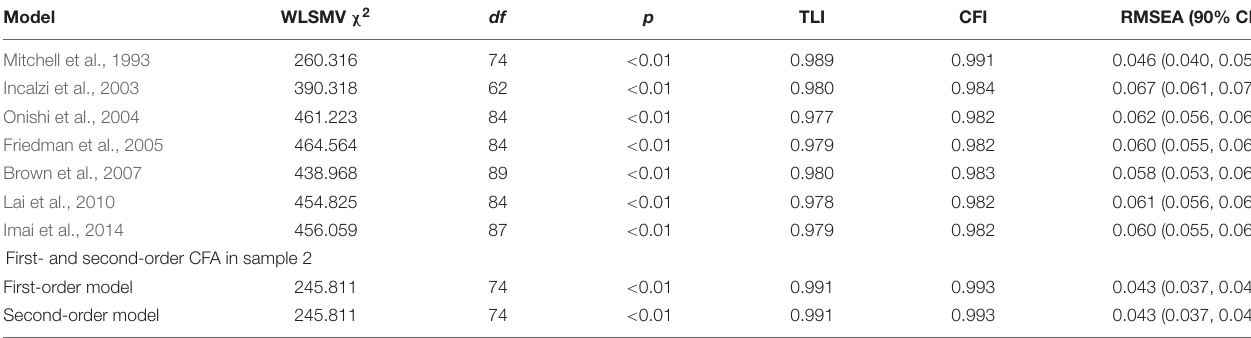
TABLE 2 | Goodness-of-fit indices of the compared